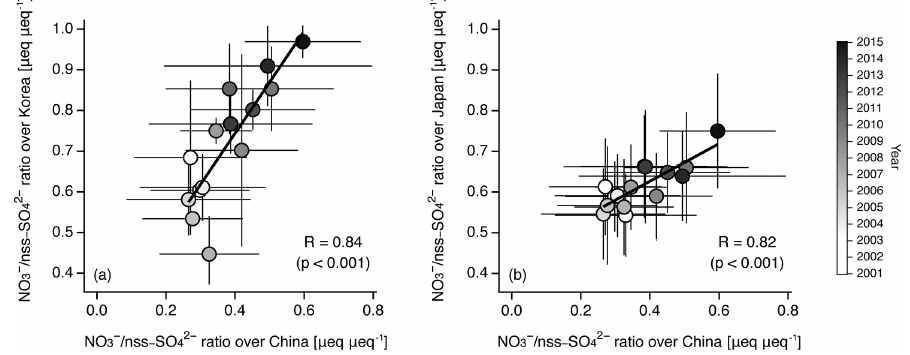
/ nss-SO 2 − concentration in precipitation ( Ratio ) in China and Korea and (b) those in China and 3 4